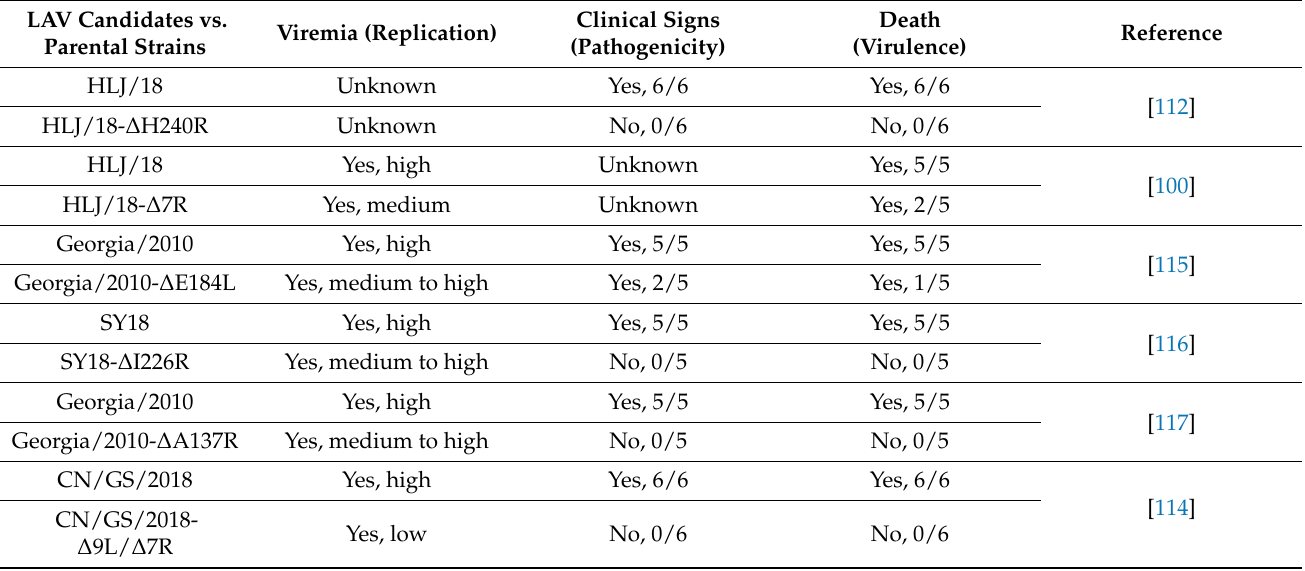
Table 2. Viremia, clinical signs, and death in LAVs-inoculated pigs compared with parental strains. Clinical LAV Candidates vs. Viremia (Replication)